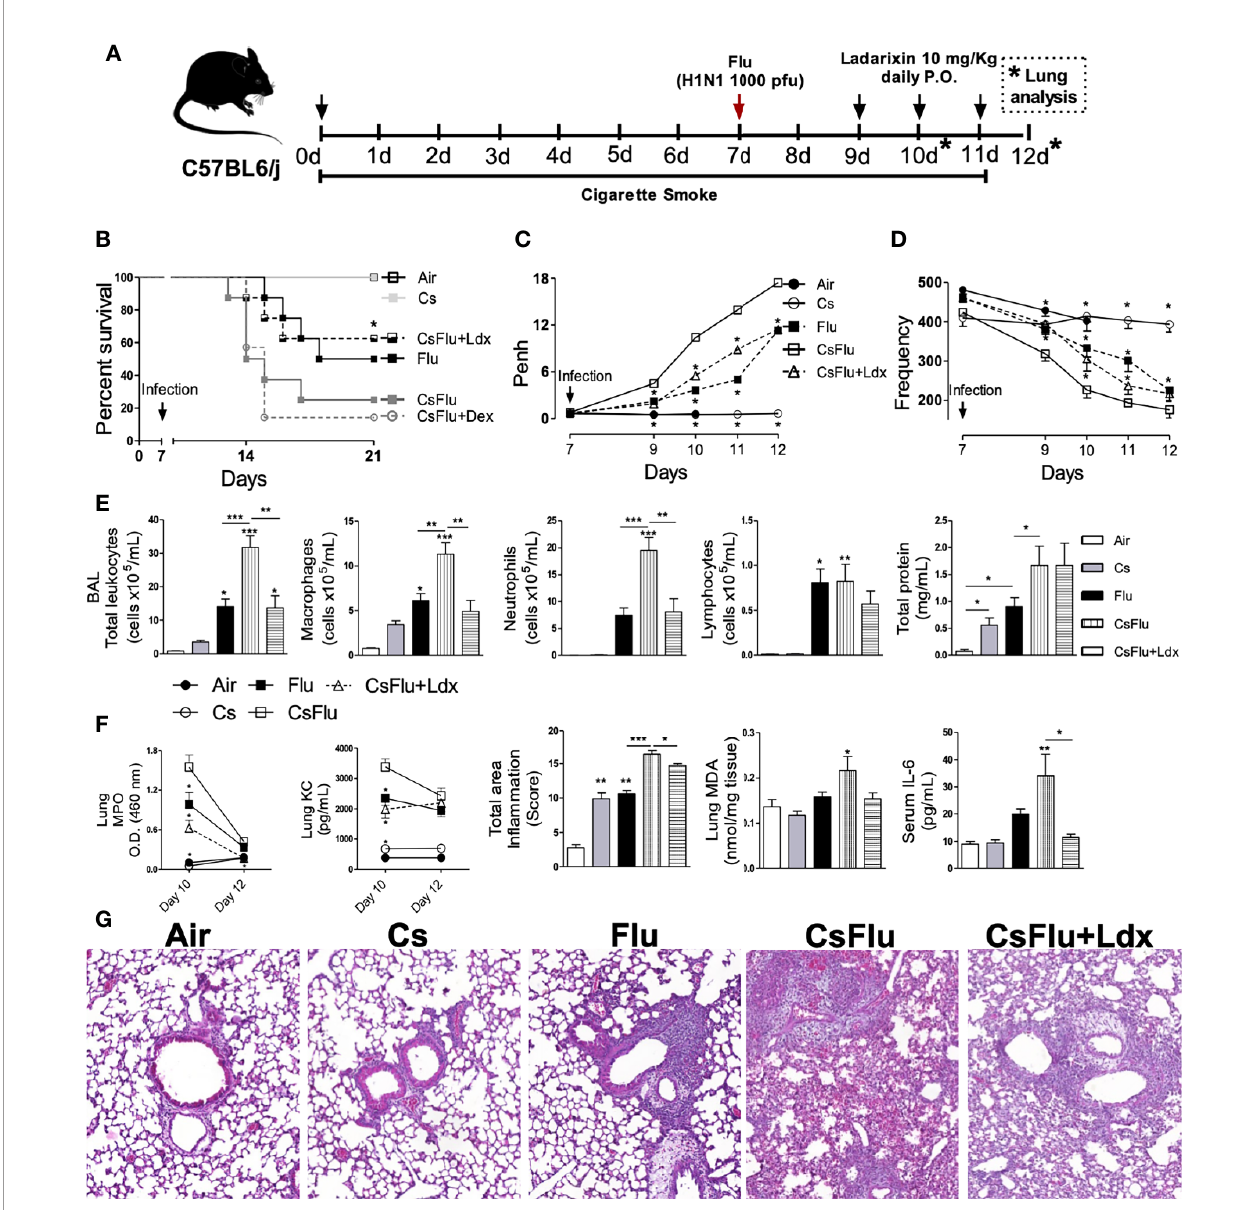
FIGURE 10 | Ladarixin protects mice from cigarette smoke-induced exacerbation of In fl uenza-A infection. (A) Schematic representation of the experimental design. (B) Survival proportions of the different groups of mice after day 7 (infection day). (C) Effect of Ladarixin on cigarette smoke (Cs)-induced exacerbation of Penh elevation in mice subjected to H1N1 infection. (D) Effect of Ladarixin over respiratory frequency on mice subjected to H1N1 infection and cigarette smoke (CsFlu). (E) BALF analysis at day 12. Assessment of leukocyte in fl ux and protein leakage into airways (F) (From right to left) Comparison of MPO activity and KC levels in lung tissue at days 10 and 12; in fl ammation score, derived from histological analyses, from lung tissue obtained at day 12; MDA levels in lung tissue at day 12; IL-6 levels in mice serum at day 12. (G) Representative histological sections of lung (H&E dye) for each group obtained at assay day 12. n ≥ 6 for each group * for P < 0.05; ** for P < 0.01 and *** for p < 0.001. For (B – D) * represents signi fi cant differences compared to CsFlu group. In MPO and KC graphs, * represents signi fi cant differences compared to CsFlu group. For the rest of the graphs in (E, F) * represents signi fi cant differences compared to Air group except when indicated with a solid